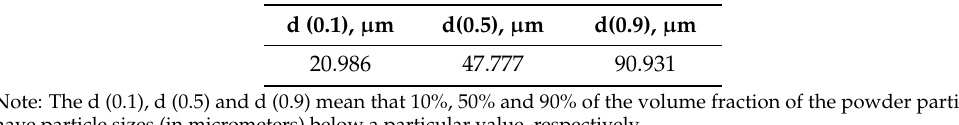
Table 3. The particle size distributions of the HDH titanium powders.